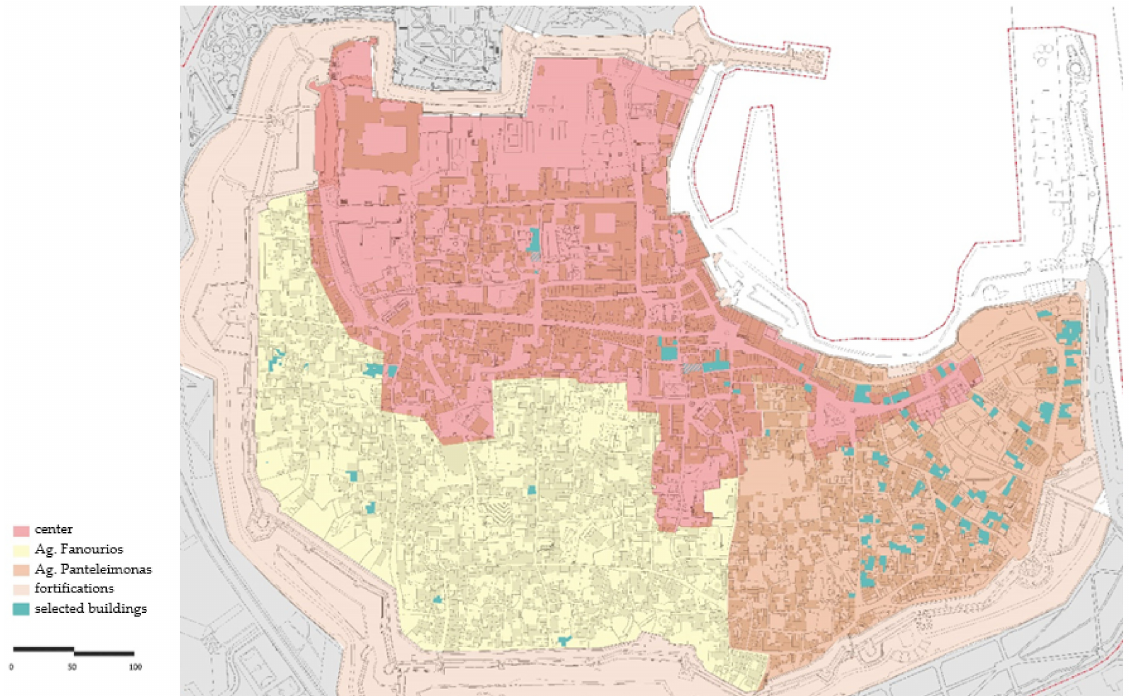
Figure 14. Neighborhoods of the Medieval City of